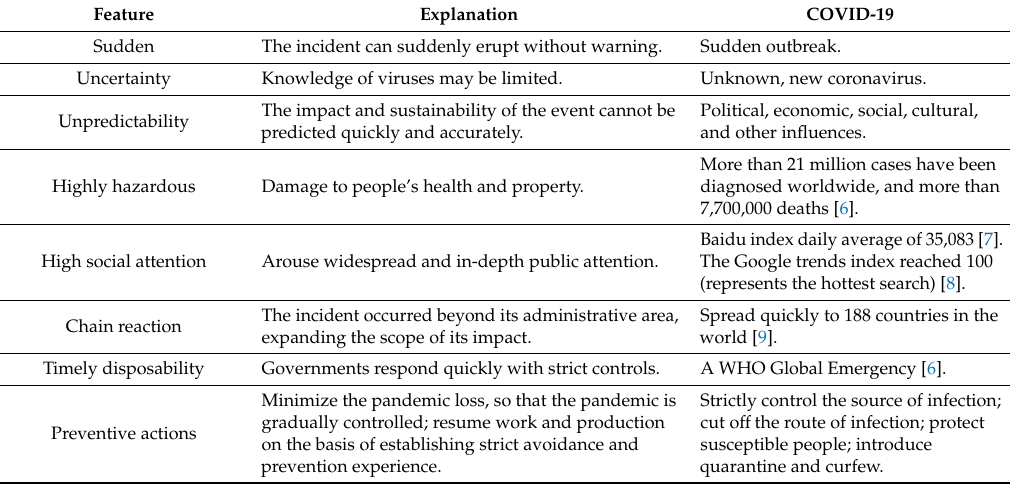
Table 1. Characteristics of COVID-19 incidents. WHO: World Health